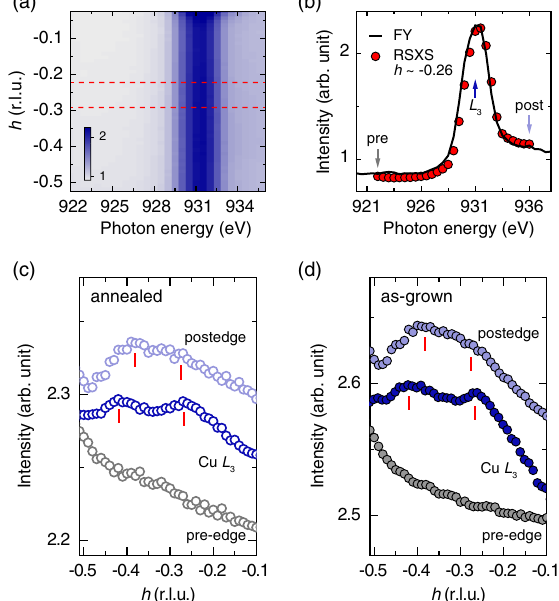
FIG. 4. Energy dependence of the reflection at q ∼ 1 = 4 . (a) The 2D map of the RSXS intensity of the as-grown NCCO at T ¼ 30 K. (b) The integrated energy profile of the as-grown I near h ∼ − 0 . 26 (red circle). The integrated range is RSXS ¼ 53 eV. indicated by red dashed lines in Fig. 3(a). The profile is compared ph to the x-ray absorption spectroscopy (XAS) spectra using fluorescence yield (FY). We show the h scans of (c) annealed and (d) as-grown NCCO ( T ¼ 30 K) at different photon energies: Cu L 3 edge, pre-edge, and postedge are 931 eV, 922 eV, and 936 eV, respectively. Data are vertically shifted without scaling for better visibility. The red vertical bars indicate the h positions of the